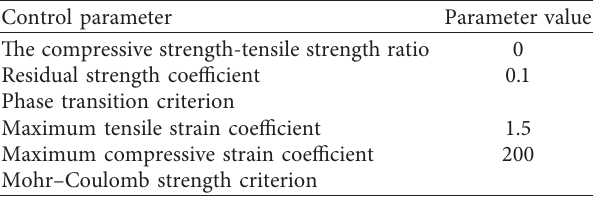
Table 1: Phase change criterion control parameters.